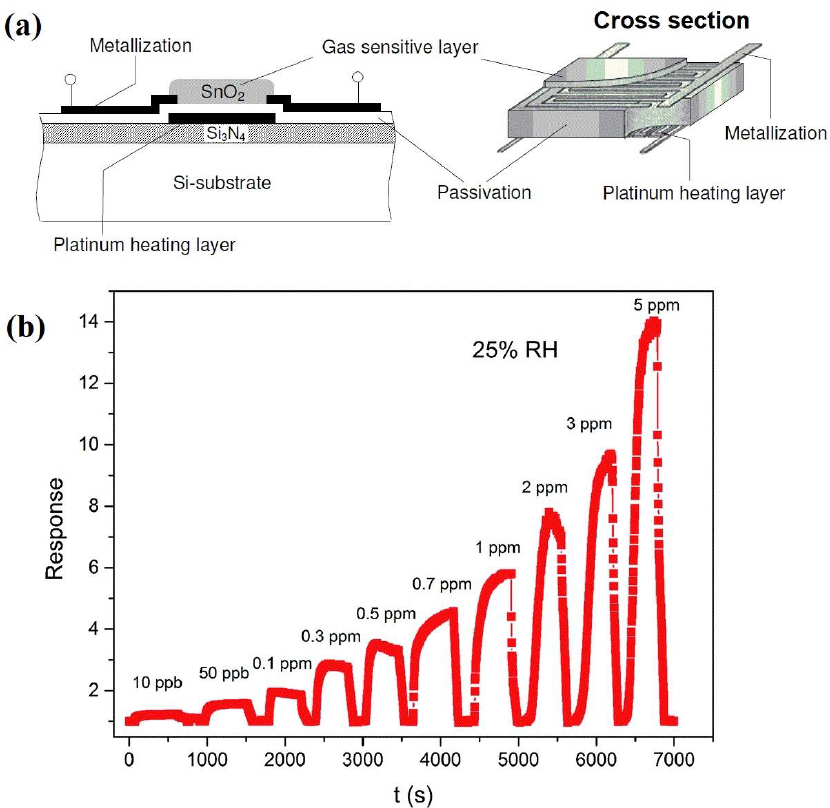
Figure 4. ( a ) Schematic illustration of a microstructured MOx-type gas sensor (adapted from [79]). ( b ) Characteristic curve of response and recovery toward acetone gas at different concentrations (adapted from [36]).